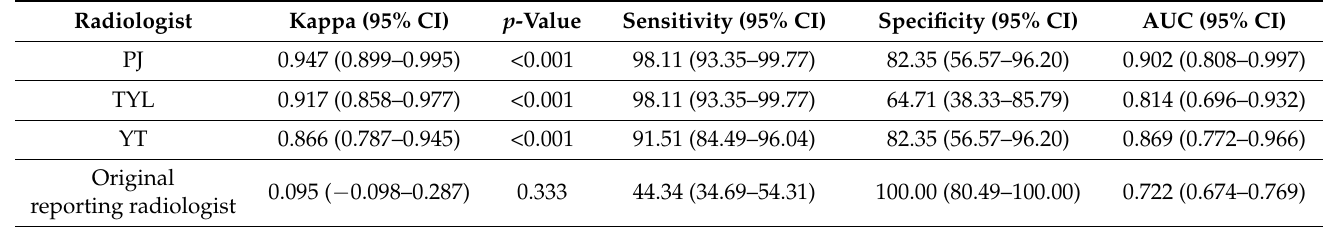
Table 9. Radiologist sensitivity, specificity, and AUCs for two-grade (normal versus low/high-grade) MESCC per CT